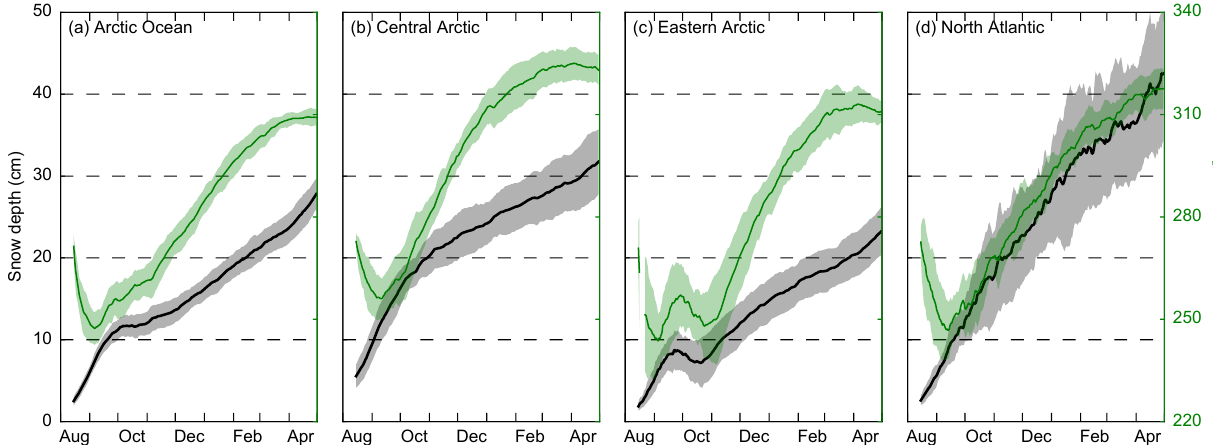
Figure 6. Seasonal snow depth (black) and bulk density (green) evolution across the four study regions (shown in Fig. 5) initiated from 15 August 2000–2014 and run until 1 May of the following year using the MEDIAN-SF/parameter settings (Table 1). The thick lines show the mean values over this time period, while the shaded areas represent the interannual variability (1 standard deviation).